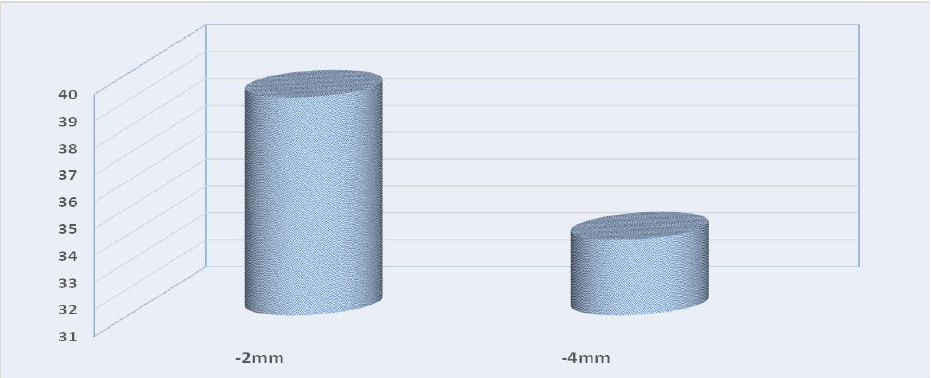
Figure 7. Comparison of mean values of temperature between all systems at − 2 and − 4 mm. There were significant statistical differences ( p = 0.000).